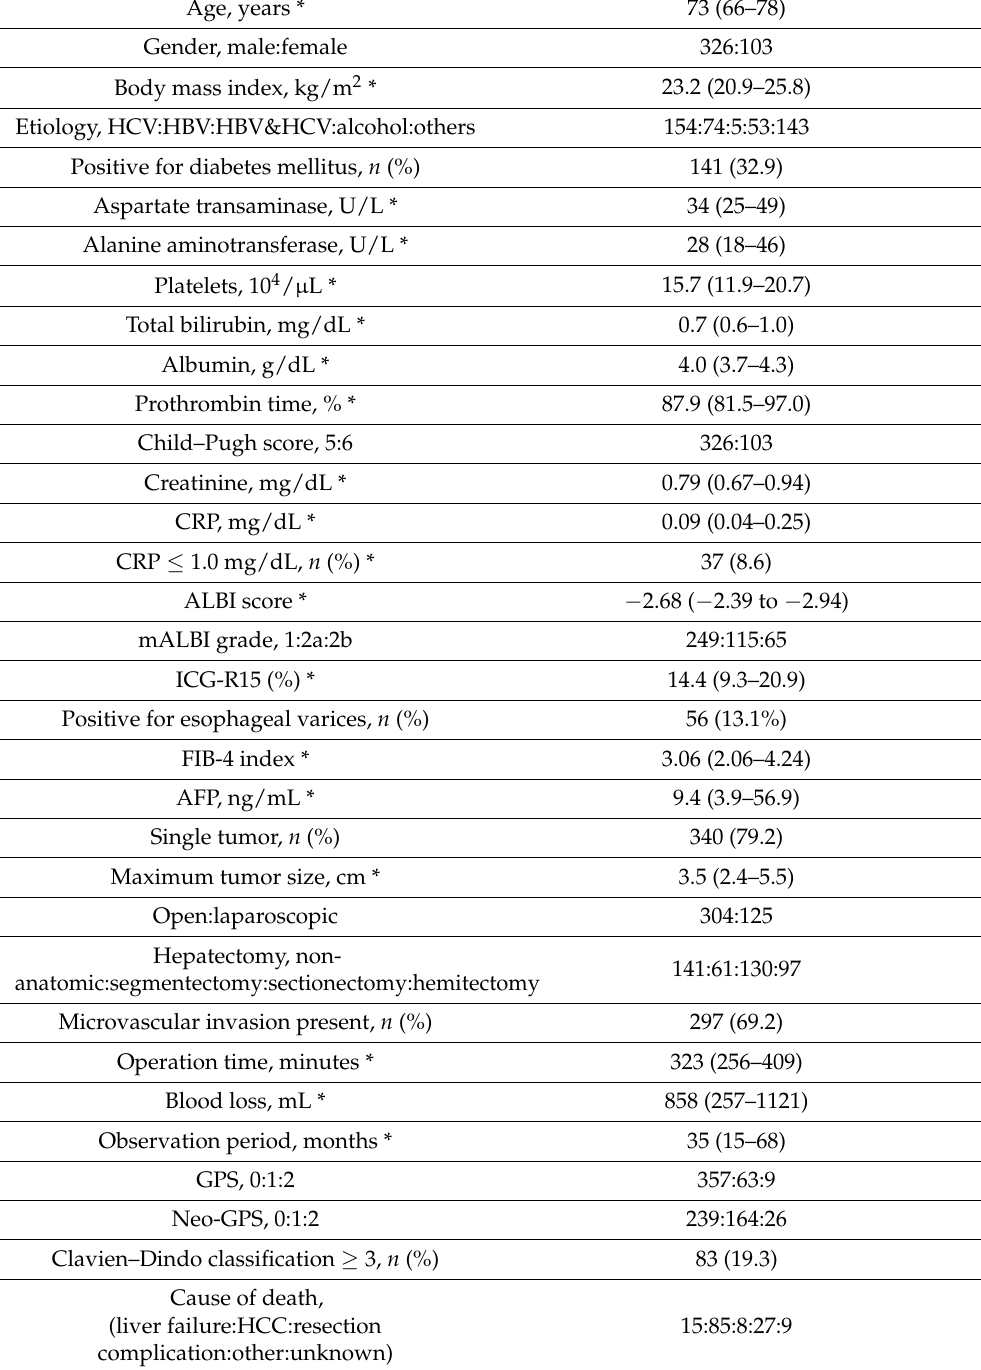
Table 1. Clinical features of patients ( n =